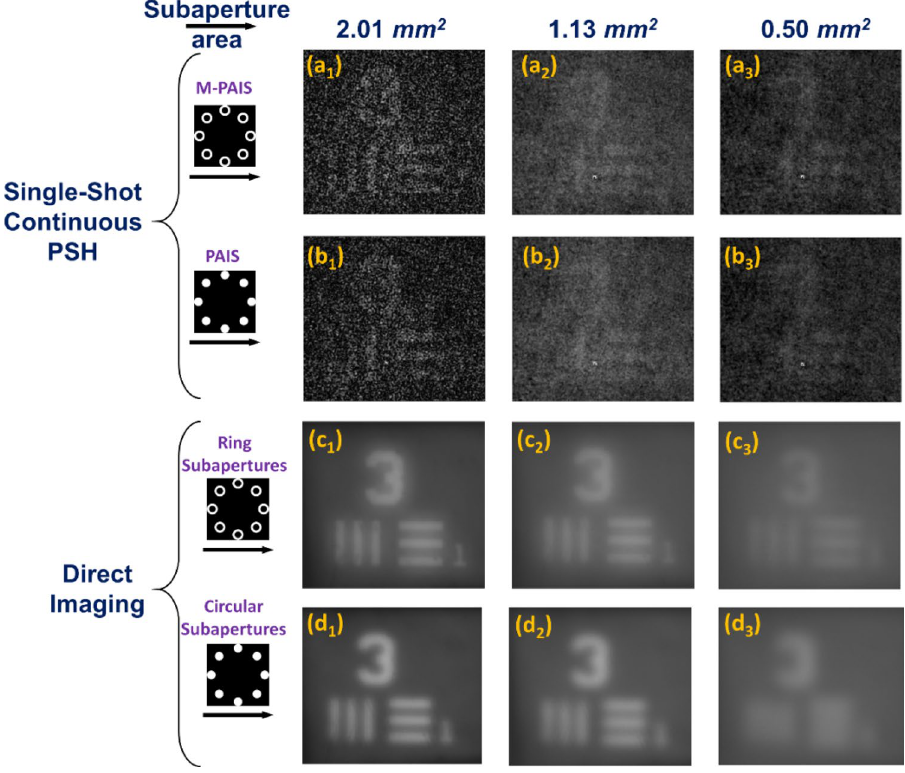
Figure 8. NLR results obtained by PSHs of continuous intensity profile, with a single-shot of ( a 1 –a 3 ) M-PAIS with NLR coefficients o = 0.32, 0.36, 0.4 and p = 0.28, 0.32, 0.32; ( b 1 –b 3 ) PAIS with NLR coefficients o = 0.32, 0.36, 0.32 and p = 0.24, 0.32, 0.40. Direct imaging through ( c 1 –c 3 ) ring and ( d 1 –d 3 ) circular subapertures; subscript numbers represent images obtained from subaperture area of 2.01, 1.13 and 0.50 mm 2